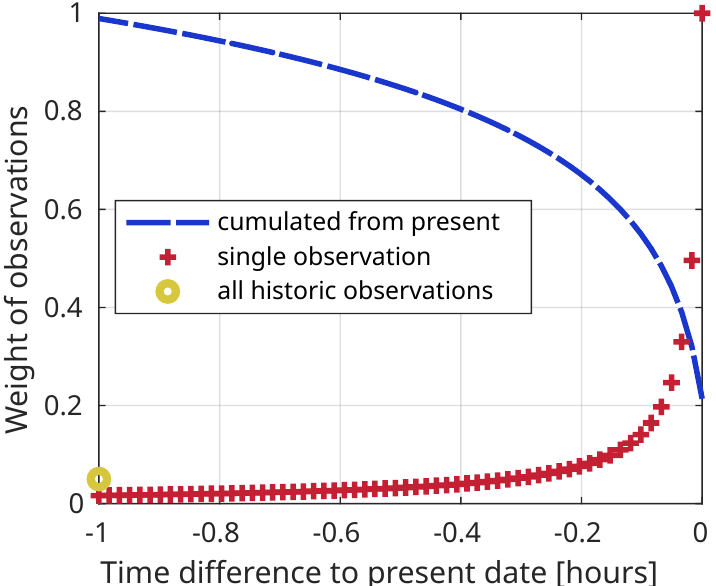
Figure 6. The plot shows the weight assigned to each observation of cloud attenuation from the same day ( + ) as well as the cumulative weight assigned to all observations from the most recent hours (blue dashed line). This example evaluates a case with a constant rate of observations. As the observation from the present timestamp is given a large weight, the cumulative weight starts at about 0.2 at a time difference of 0 h. All historic observations (i.e., those from previous days) together are assigned a small weight of 0.05 ( ◦ ). These observations only contribute noticeably if there are no recent observations at a similar attenuation